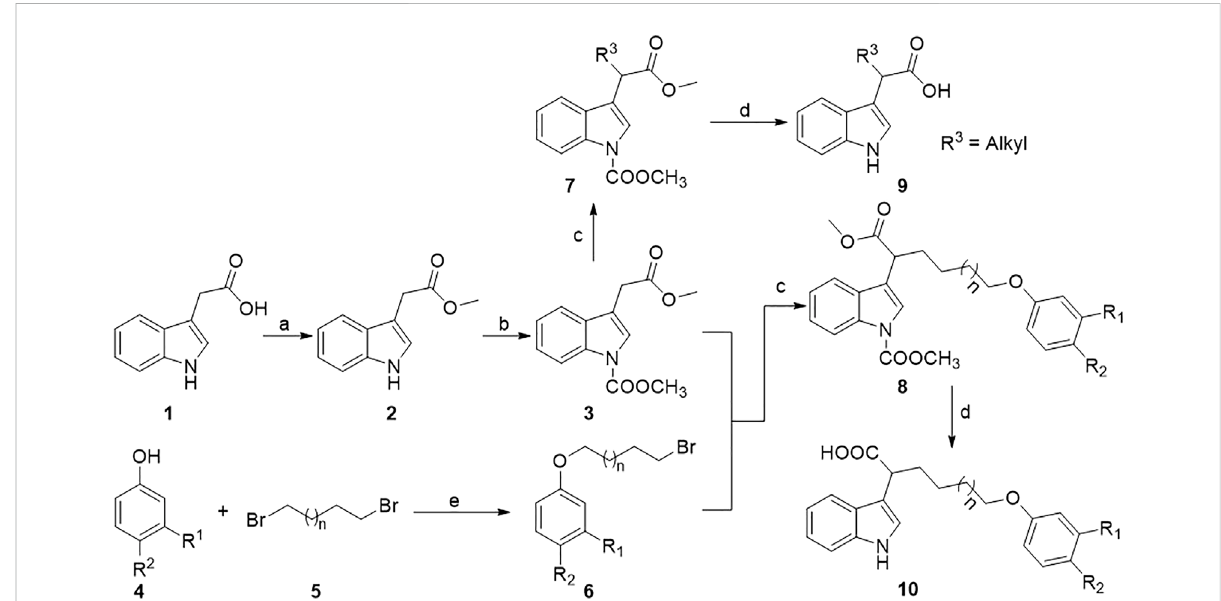
FIGURE 3 Synthetic route of α -substituted indole-3-acetic acids. Reagents and conditions: a) DCC, DMAP, MeOH, dry CH 2 Cl 2 , r.t.; b) TEBAC, methyl chloroformate, DCM, 30% NaOH ( aq. ), ice bath; c) R-Br, LDA, HMPA, THF, − 78 ° C – 0 ° C; d) 30% NaOH ( aq. ): CH 3 OH = 1:2 (v/v), 70 ° C, 4 h, 2 M HCl.